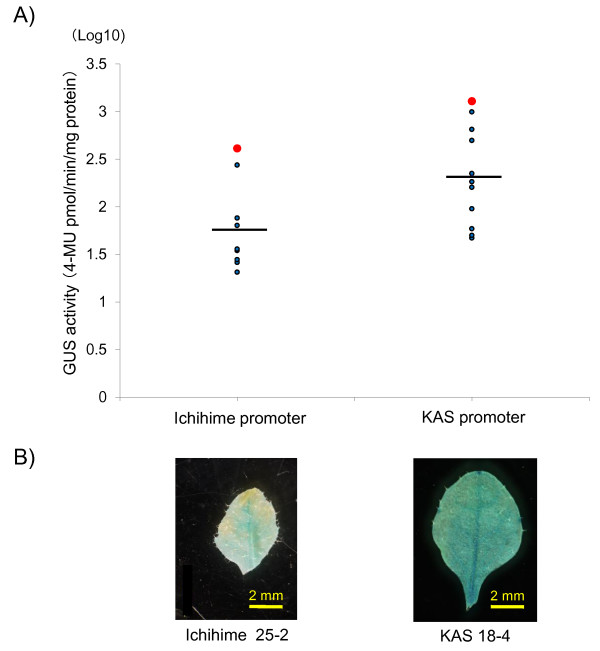
GUS activity and histochemical analyses of transgenic Arabidopsis plants. (A). Log-transformed values of GUS activity of T2 plants harboring Ichihime or KAS γ-TMT3 promoter are shown. Each blue dot represents value of independent T2 plant. Red dots represent T2 plants with the highest GUS activity, Ichihime 25-2 for Ichihime promoter and KAS 18-4 for KAS promoter. Black bar represents average value of T2 plants. (B). GUS histochemical anlaysis of leaves from T2 plant harboring Ichihime γ-TMT3 promoter (Ichihime 25-2) and T2 plant harboring KAS γ-TMT3 promoter (KAS 18-4).